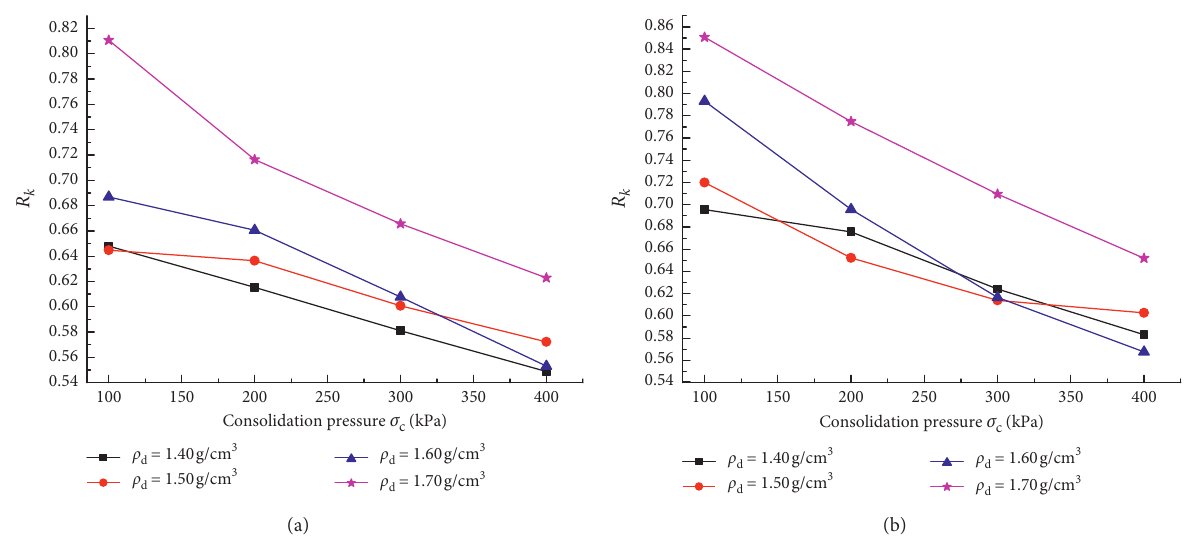
Figure 12: Saturated permeability ratio of compacted loess under K horizontal direction. (b) R k in the vertical direction.